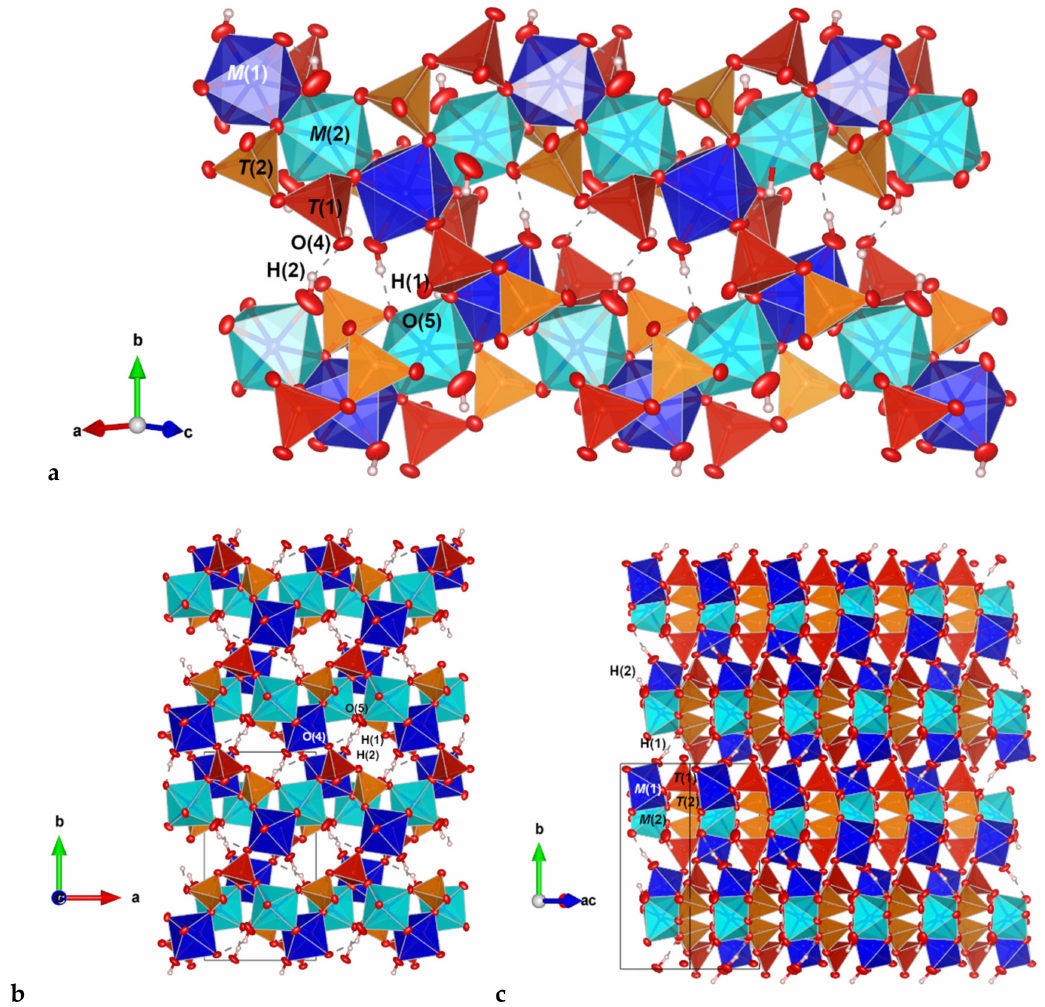
Figure 4. Orthographic projections of the crystal structure of rüdlingerite on the plain (the orientation is shown inside the figure), showing details of the chains of Mn-centred octahedra and the linking through the T 2 O 7 groups ( a ), the cavities along [001] hosting the hydrogen bonds ( b ) and the alternance of bent chains along [010] ( c ). Oxygen atoms are reported in red as anisotropic displacement parameters. Hydrogen atoms are in white. Diagrams obtained using VESTA 3.0